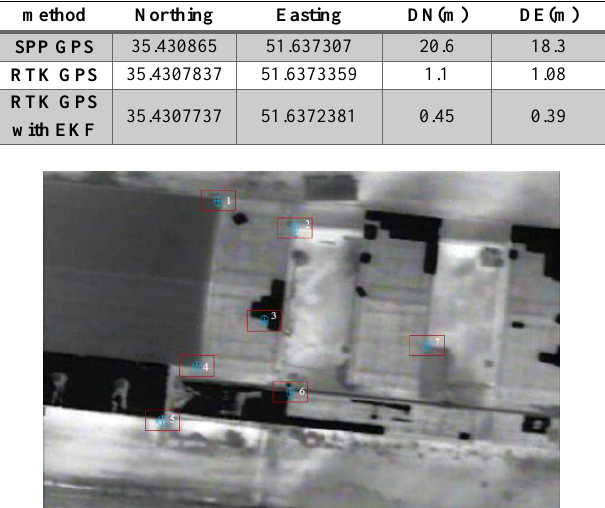
Table 3: Standard deviation in geolocation for target 1